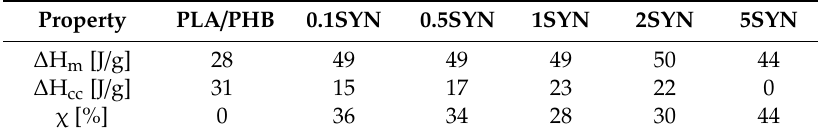
Table 3. Thermal properties of the neat blend and HLB12-containing systems.